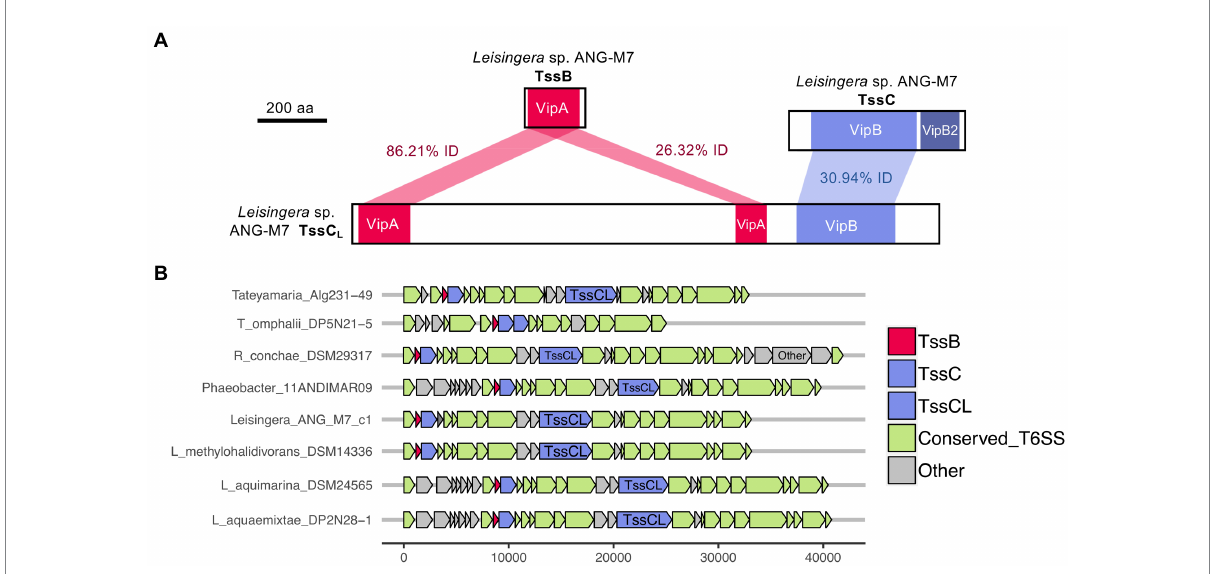
FIGURE 6 Domains and occurrence of the Alphaproteobacteria sheath protein, TssC L . The long copy of the TssC protein, termed here TssC L , contains domains from both TssB and TssC and was only detected in other roseobacter reference genomes in this study. (A) The TssC L protein of Euprymna scolopes ANG symbiont Leisingera sp. ANG-M7 contains two VipA domains with 86.21% (1e − 94 E-value) and 26.32% (5e − 5 E-value) amino acid identity to the VipA domain in TssB. This TssC L protein also has a VipB domain with 30.94% identity (2e − 36 E-value) to the VipB domain in TssC. (B) Other roseobacter genomes that have a tssC L gene still have tssB and tssC genes. Some roseobacter genomes, such as Tateyamaria omphalii DP5N21–5, do not have tssC L , but instead have two tssC genes and one tssB